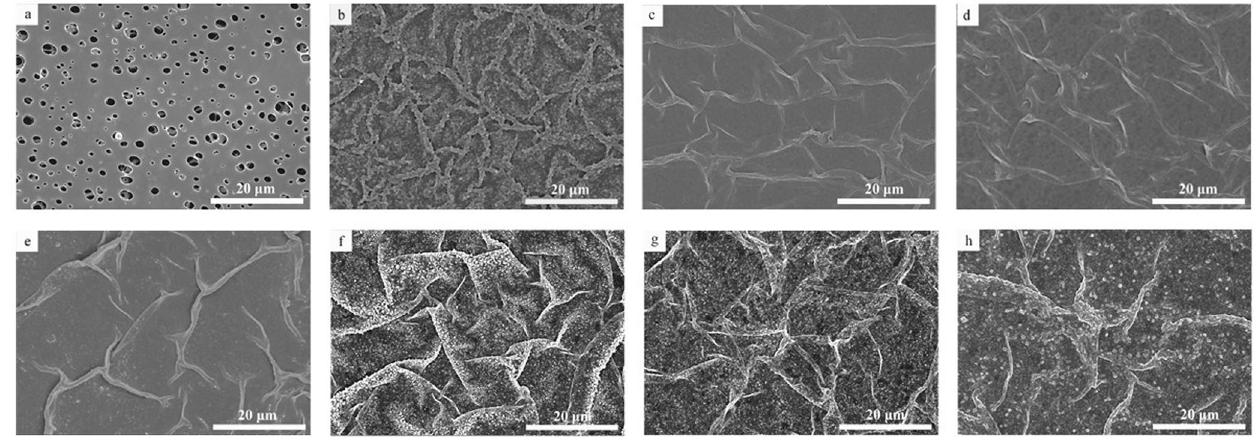
Fig. 4 SEM images of composite NF membrane. SEM images (scale bar: 20 μ m) of a PES substrate, b TFC, c L-SCNF-0.01, d M-SCNF-0.01, e H-SCNF-0.01, f L-SCNF/Ag-0.01, g M-SCNF/Ag-0.01 and h H-SCNF/Ag-0.01.